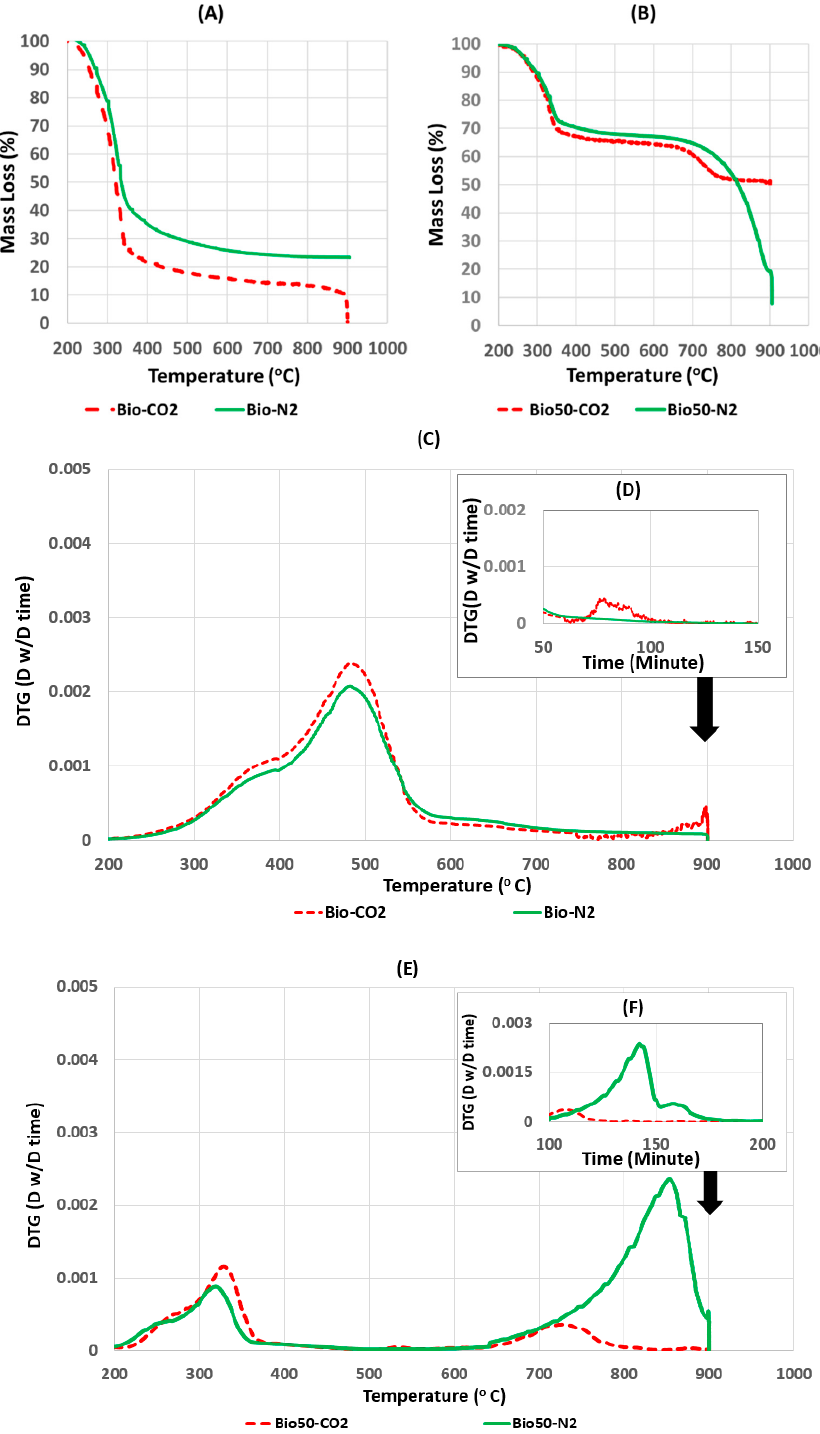
Figure 5. TGA mass changes ( A , B ) and DTG curves ( C – F ) of Bio and Bio50 thermochemical conversion under N 2 and CO 2 at 900 °C.